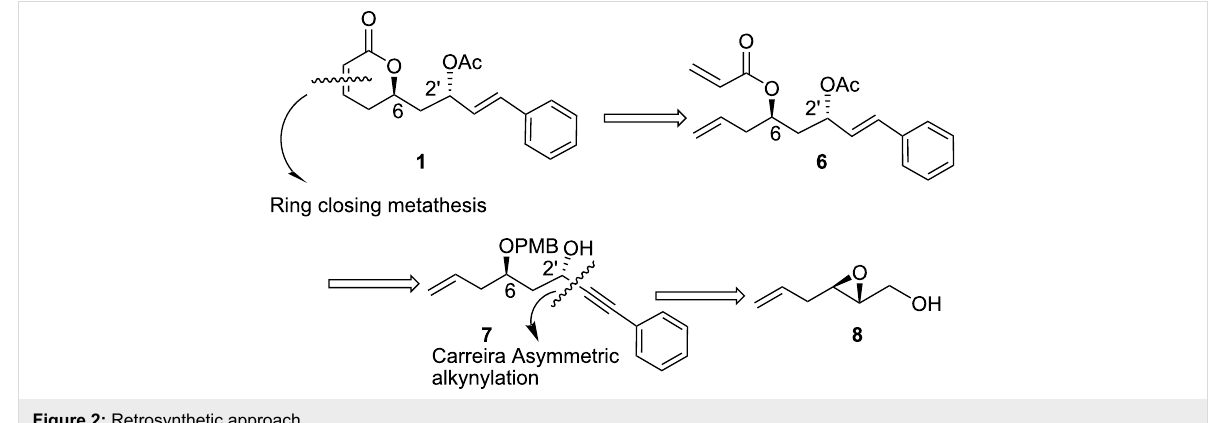
Figure 2: Retrosynthetic